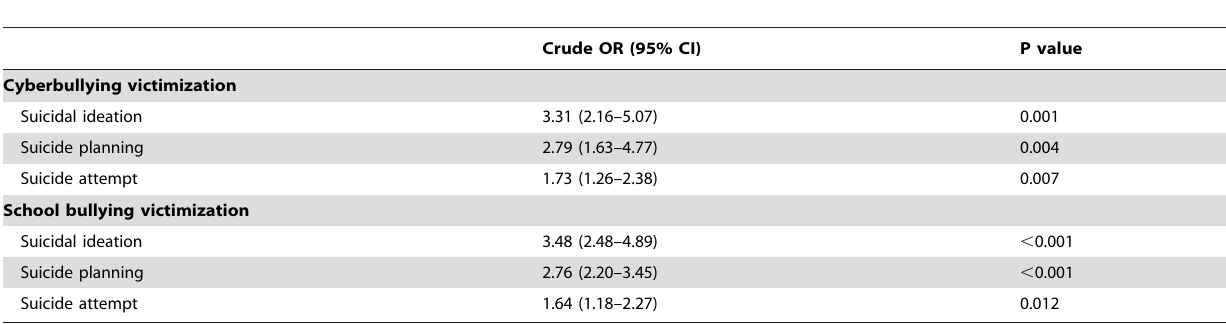
Table 3. Associations between cyberbullying and school bullying victimization and suicidal ideation, plans and